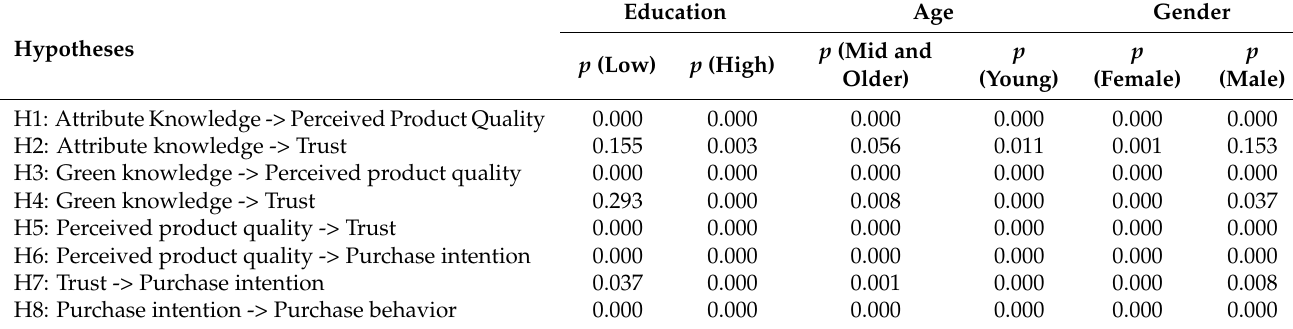
Table 10. Multigroup analysis